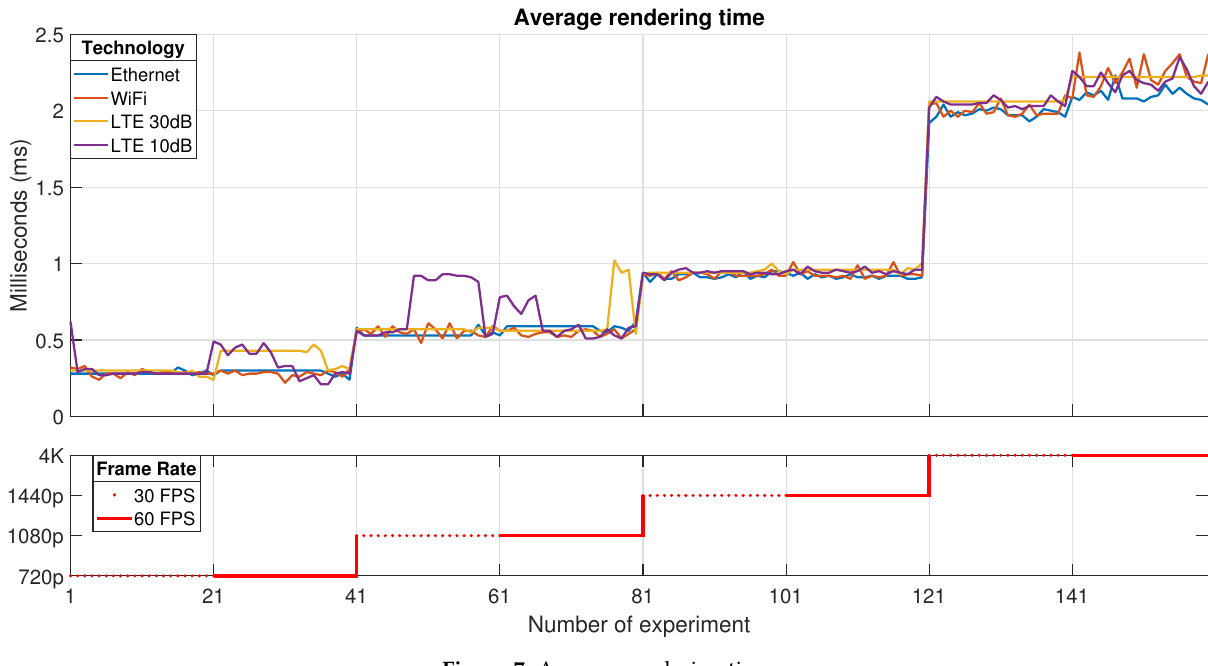
Figure 7. Average rendering time.